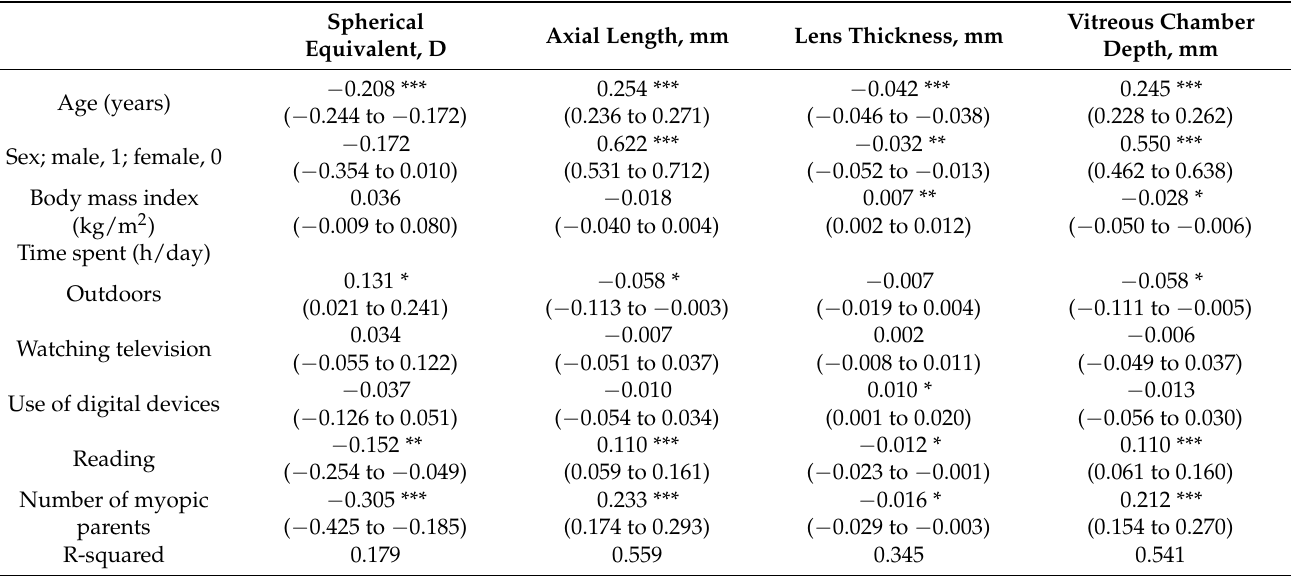
Table 4. The associations between ocular parameters and lifestyle by multiple linear regression